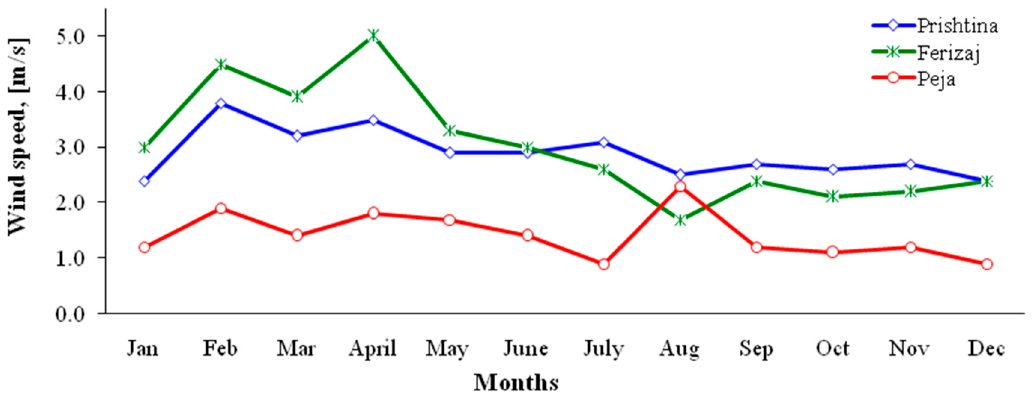
Figure 2. Monthly wind speeds at three different zones in Kosovo [17].